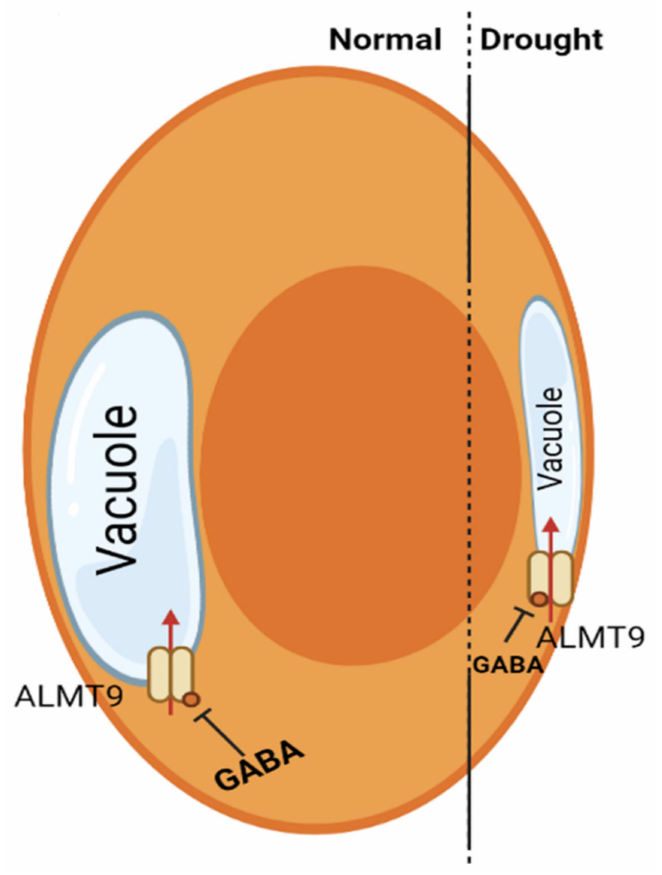
Figure 3. A model for the regulation of water-use efficiency via GABA-mediated signaling adapted from Xu et al. (2021) [55]. During severe drought, production and storage of leaf GABA de- creases ALMT9-mediated vacuolar anion absorption into guard cells, which requires the amino acids F243/Y245 (red dot) (right guard cell of pair). Compared to guard cells under normal condi- tions in the light, this reduces stomatal opening and pore apertures and increases plant water-use efficiency (WUE) during drought stress (left guard cell of